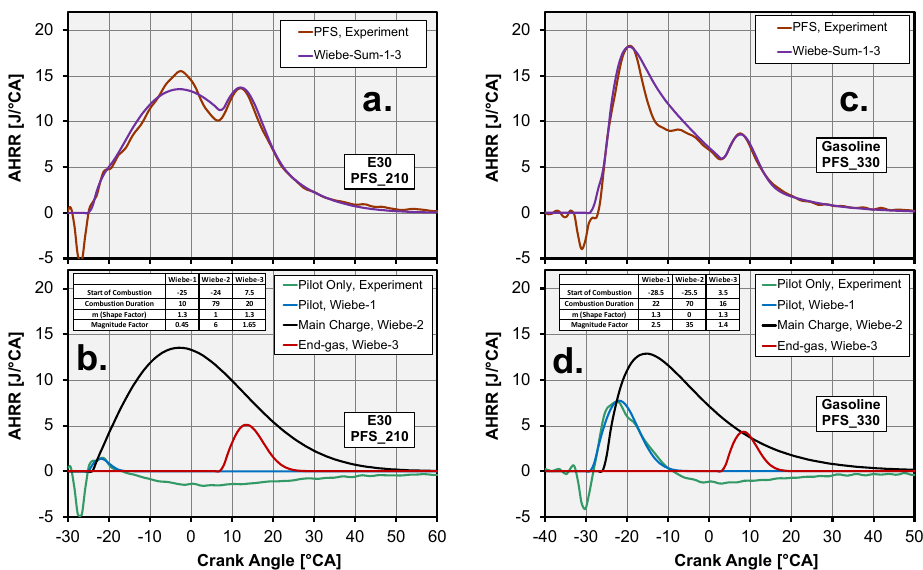
Figure A4. Reconstruction of the experimentally measured AHRR using a combination of three separate Wiebe functions for PFS_210 combustion case ( a , b ) and PFS_330 combustion case ( c , d ).